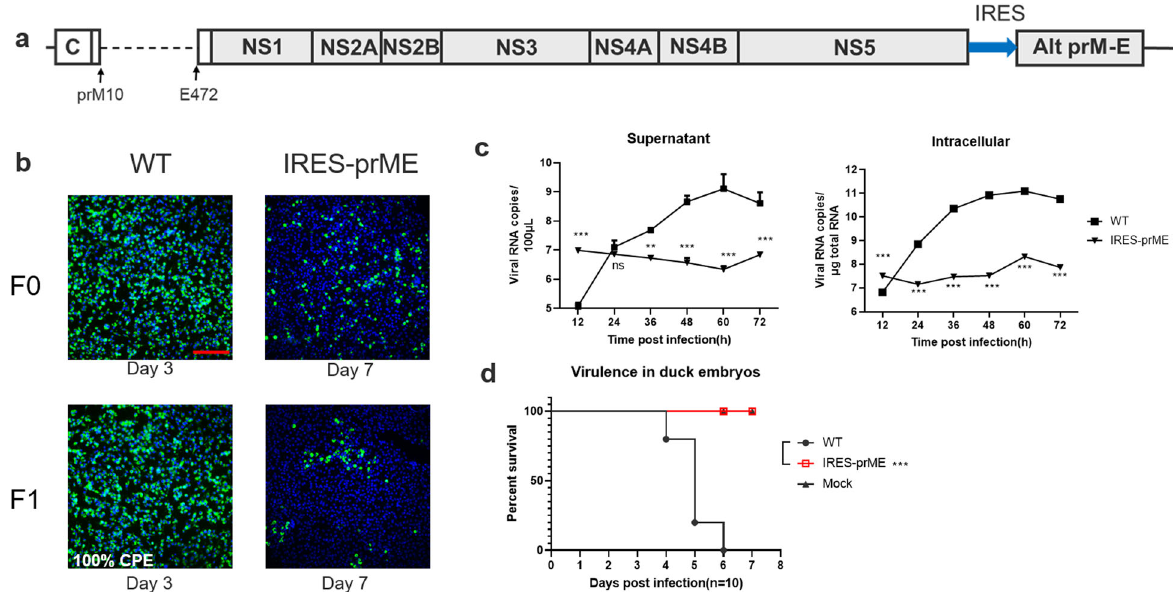
Fig. 6 Recombinant TMUV ectopically expressing prM-E protein. a Schematic diagram of the construction of CQW1-IRES-prME ectopically expressing prM-E protein. b Recovery of CQW1-IRES-prME con fi rmed by IFA. BHK-21 cells were transfected with pACNR-FL-CQW1-IRES-prME plasmids (F0), and 7 dpi, the supernatants were harvested for the next generation to verify viral infectivity. The length of the scale bar (displayed in a red line segment) represents 400 μ m. c Growth kinetics of CQW1-IRES-prME measured by RT – qPCR. d Virulence of the CQW1- IRES-prME viruses in 9-day-old duck embryos. The data are presented as the means and SEMs; signi fi cance was de fi ned by * p < 0.05; ** p < 0.01; *** p < 0.001, and ns indicates no signi fi